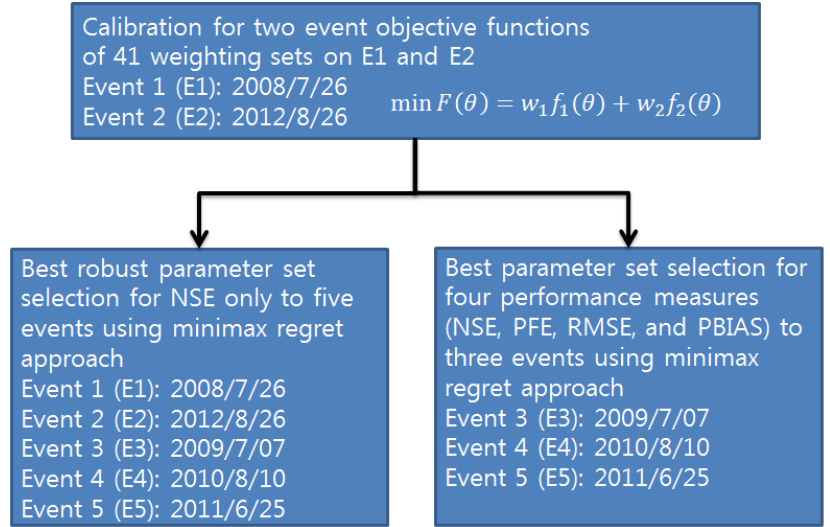
Figure 1. Parameter selection